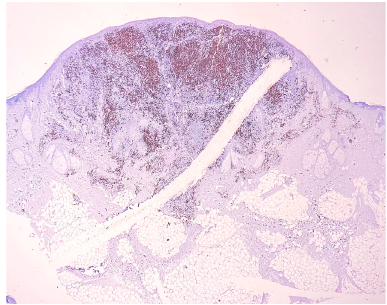
Figure 4. CD20 staining. Magnification 20×. CD3: positive in 65–70% of infiltrate lymphocytes (T lymphocytes). This highlights